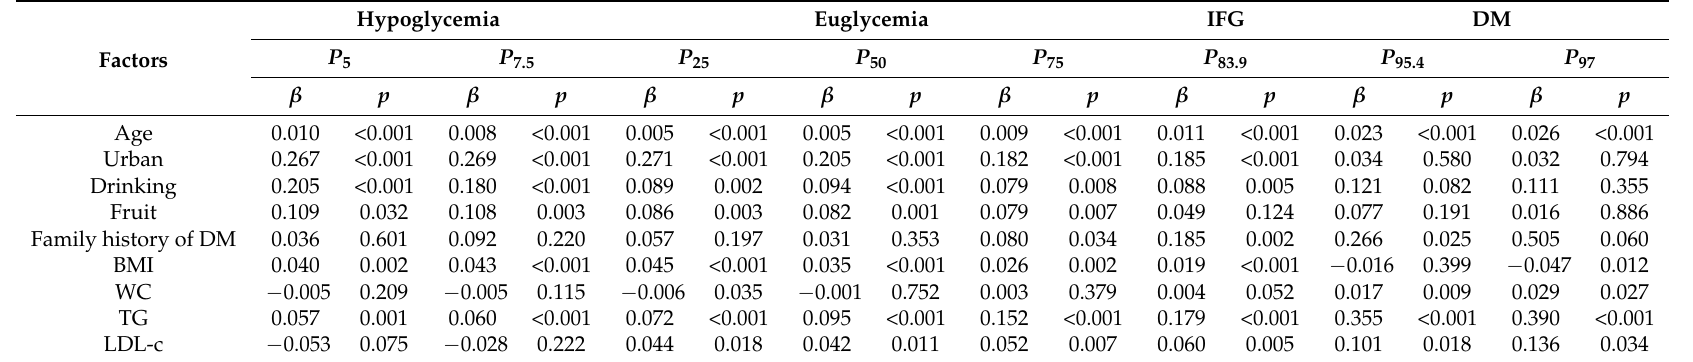
Table 2. Quantile regression coefficients between FBG and variables for males.